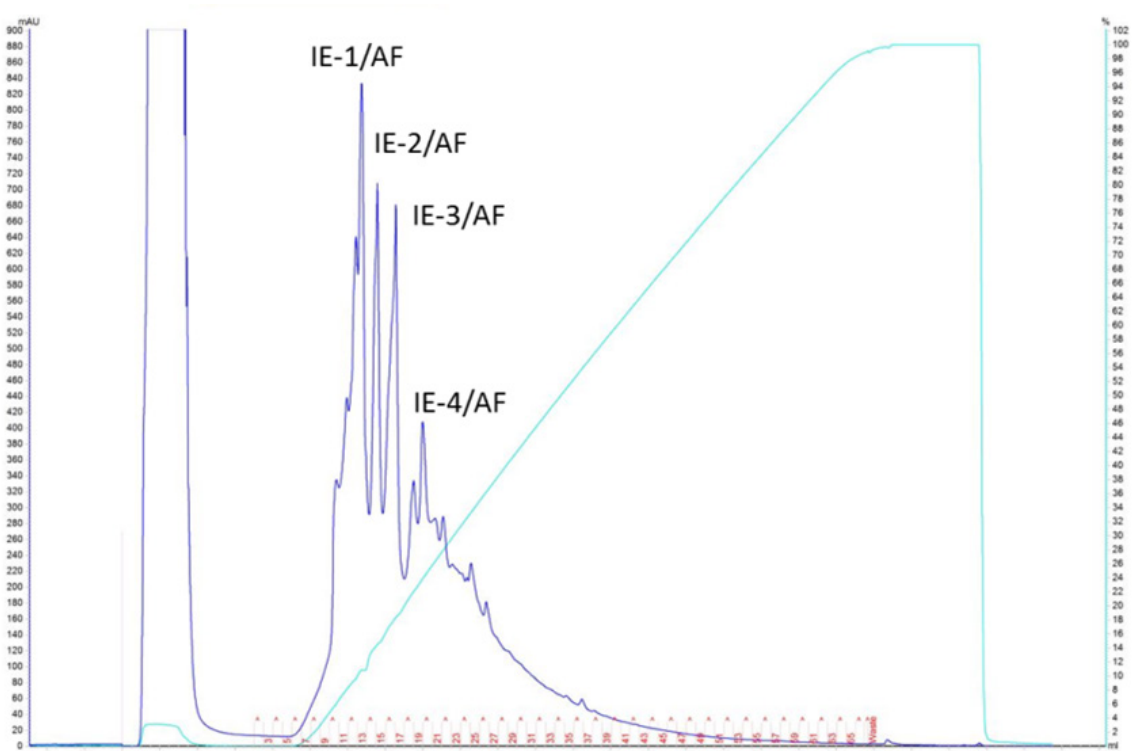
Figure 3. Chromatogram of 1E-1/AF using RP chromatography, UV A ). spectrum (DAD A 200 - 280